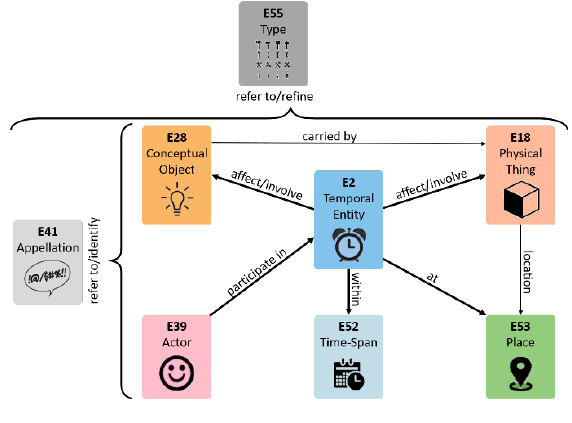
Figure 3. The CIDOC CRM